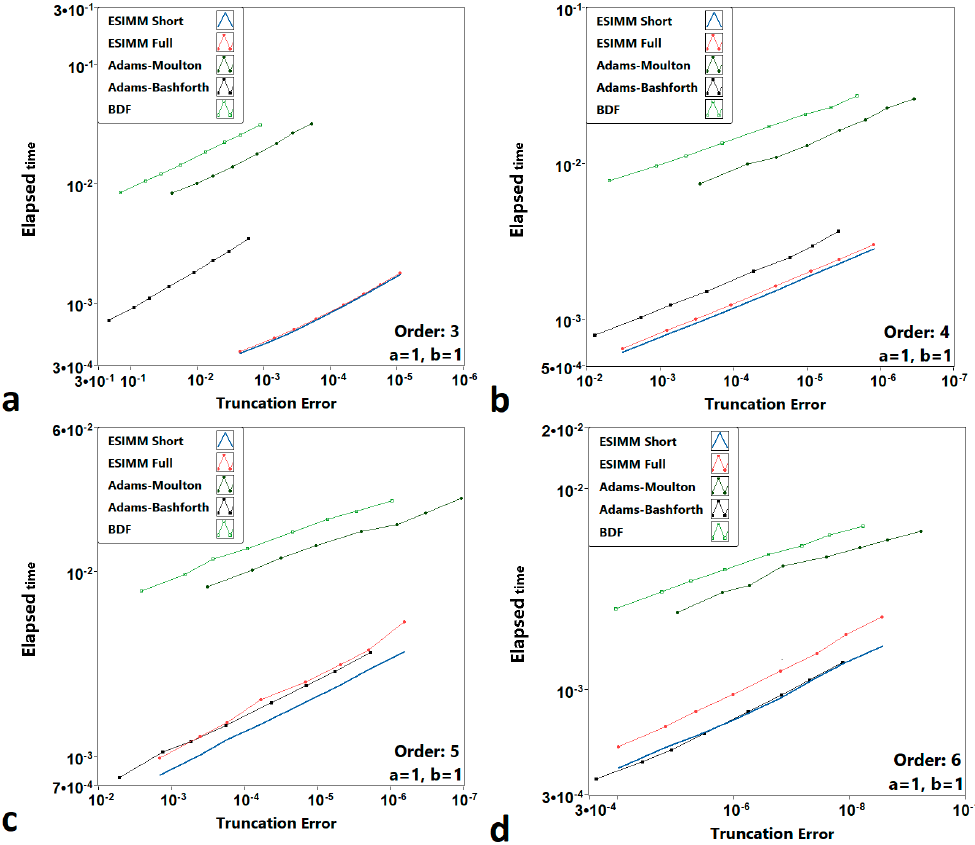
Figure 4. Performance plots for simulating Sprott Case A system by various multistep methods with the accuracy of order 3, ( b ) order 4, ( c ) order 5 and ( d ) order 6.